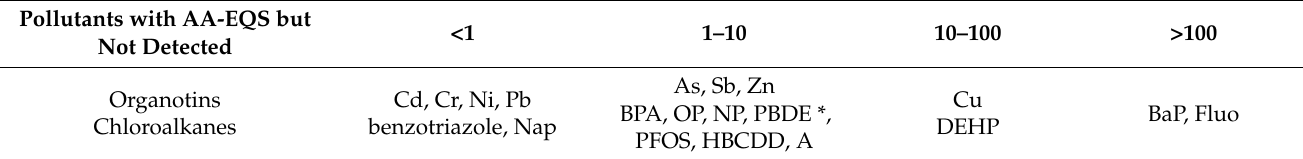
Table 9. Importance of the EMC/AA-EQS ratio, with the EMC:highest site mean EMC (the total concentrations are considered for organic micropollutants and dissolved concentrations for metals) and AA-EQS environmental quality standard expressed as the annual average concentration. (French regulatory values [30] or INERIS suggested guidance